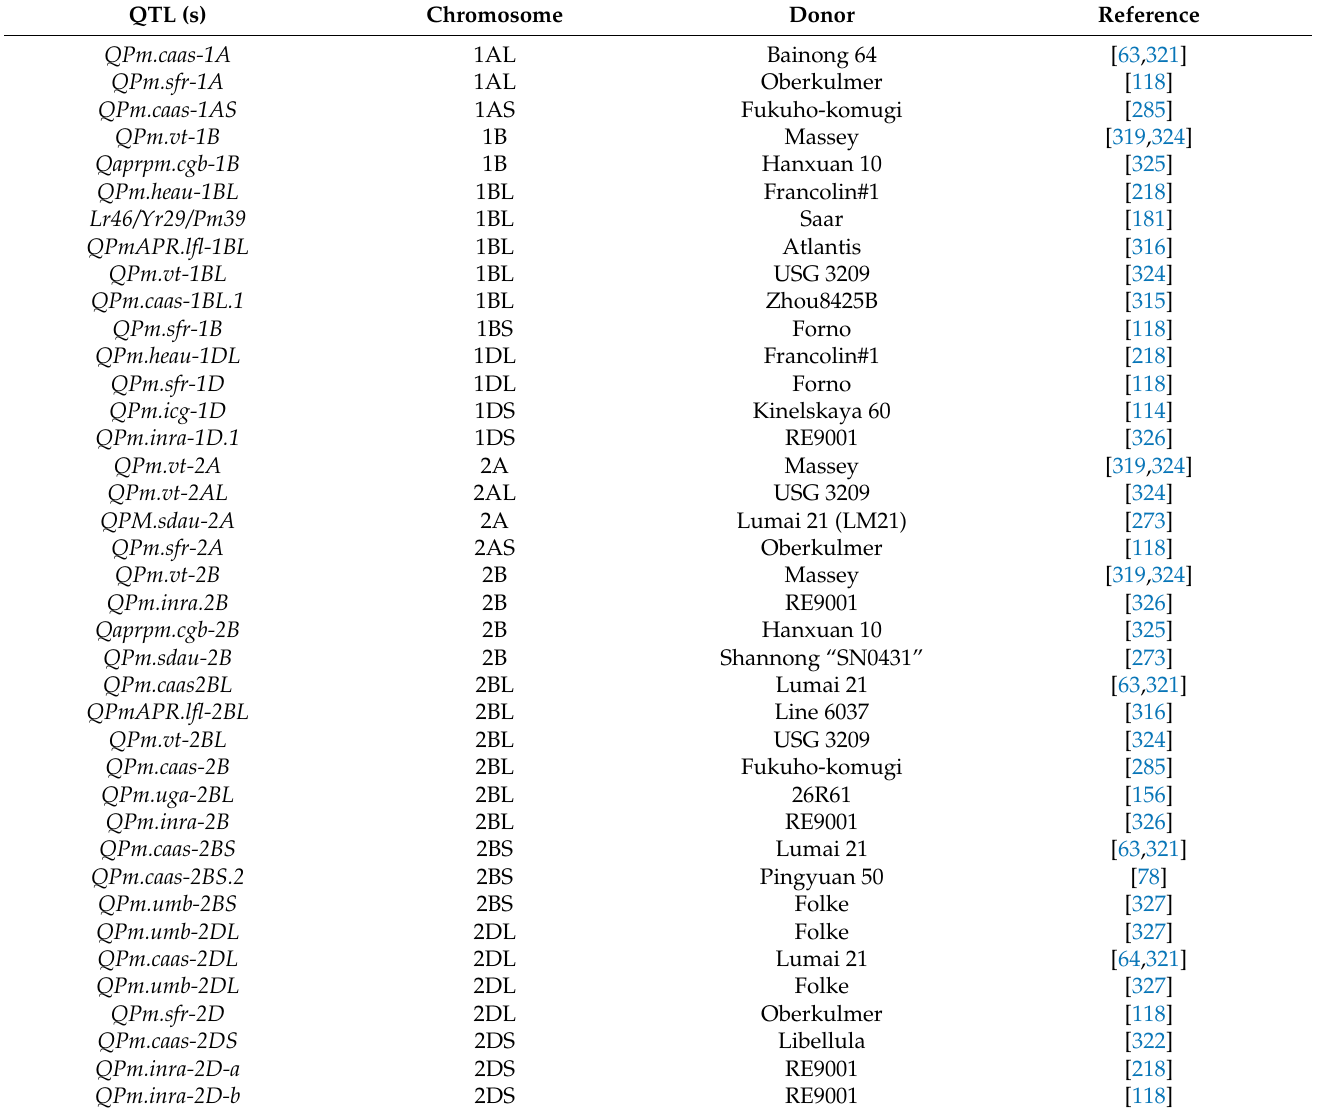
Table 4. Summary of reported quantitative trait loci (QTL) for resistance to wheat powdery